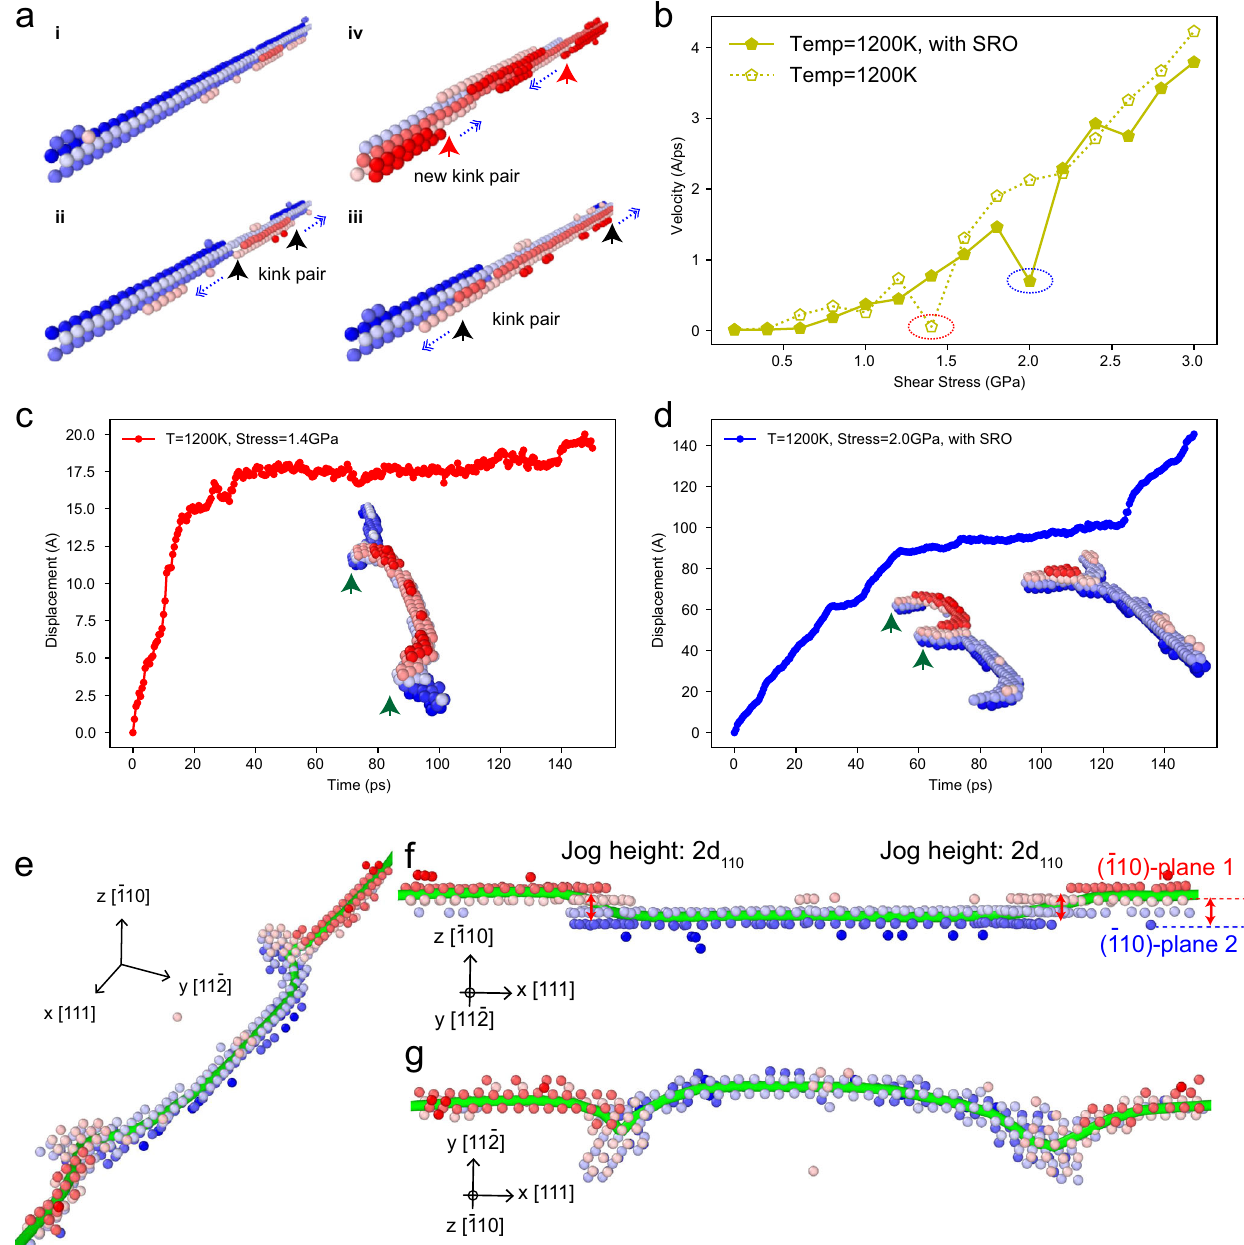
Fig. 3 Kink nucleation mechanism and the observation of cross-slip locking. a Snapshots of atomic con fi gurations along the screw dislocation, illustrating kink nucleation during glide. (i) The initially straight screw dislocation line. (ii) A kink pair nucleates (indicated by the black arrows) and migrates along the dislocation line (dashed arrow). (iii) Kink-pair migration leads to the net motion of the screw dislocation line. (iv) Another kink pair nucleates (indicated by the red arrows) and migrates. Only the dislocation core atoms are shown and the atoms are colored by coordinates in the glide direction ½ 1 (cid:1) 12 (cid:2) . b Simulation velocity vs. stress results for the screw dislocation at 1200 K; the circles show anomalous points yielding a signi fi cantly lower average velocity, associated with the formation of cross-slip locking. Details of the dislocation con fi gurations are shown in ( c , d ). c Displacement vs. time curve of a screw dislocation under a shear stress of 1.4 GPa at 1200 K in the random sample. The inset shows the formation of cross-slip locking during screw dislocation glide. d Corresponding displacement vs. time curve of a screw dislocation under a shear stress of 2.0 GPa at 1200 K in the SRO sample. The inset fi gure shows the formation and unlocking of cross-slip locking during screw dislocation glide. e Perspective view of the dislocation line with cross-slip locking. The blue region and red region are on slip planes with different z coordinates. f Dislocation line with cross-slip locking viewed from the y direction. The red segment of the dislocation line in on plane 1 and the blue segment is on plane 2; the two segments are connected by two jogs with a height of 2 d 110 . g Dislocation line with cross-slip locking viewed from the z direction. In e – g , only the atoms around the screw dislocation line are shown and are colored by the coordinates in the z direction. The green line represents the <111> screw dislocation